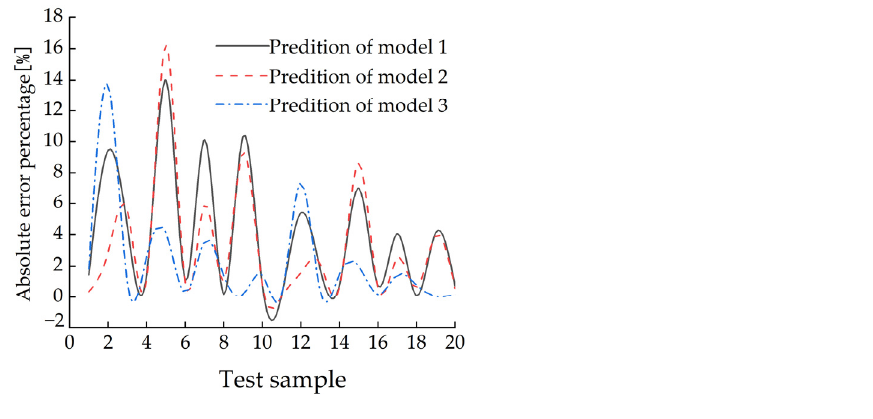
Figure 33. Prediction absolute error percentage of three models. Table 5. Summary of the prediction results of the three prediction models on the test